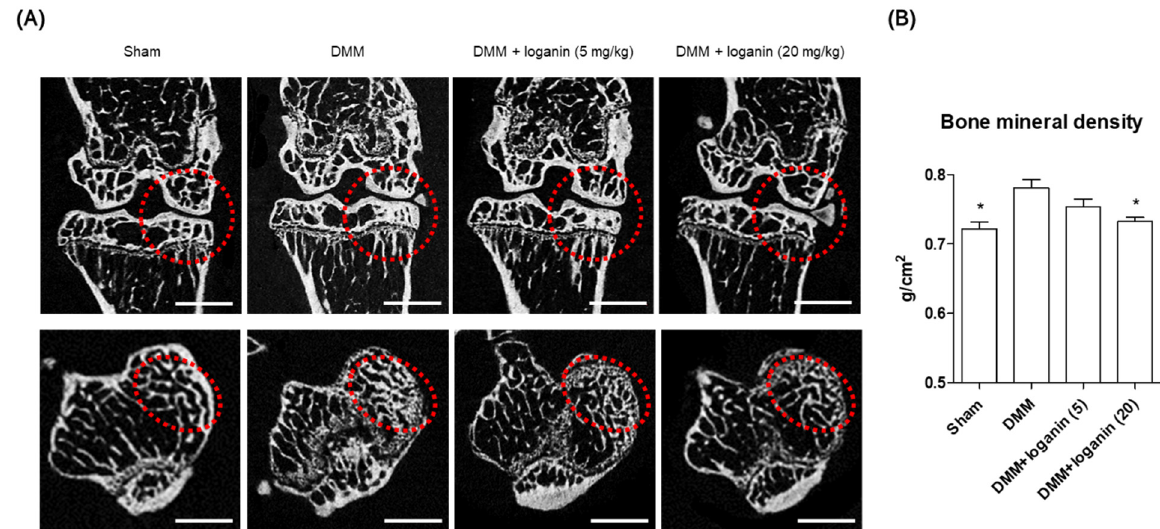
Figure 7. Loganin prevents DMM-induced tibial subchondral osteophyte formation in mice. ( A ) Representative 2D- reconstructed images of tibial subchondral bone in DMM surgery mice following loganin (5 and 20 mg/kg/day) administration or in sham-operated mice obtained by micro-CT analysis (n = 5 per group). Sham = sham-operated. Scale bar: 1 mm. ( B ) Bone mineral density (BMD) of proximal tibial epiphysis was analyzed using one-way ANOVA (Tukey’s honest significant difference post-hoc test, analysis of variance). * p < 0.05 vs. DMM. Sham = sham-operated; DMM = destabilization of medial meniscus.